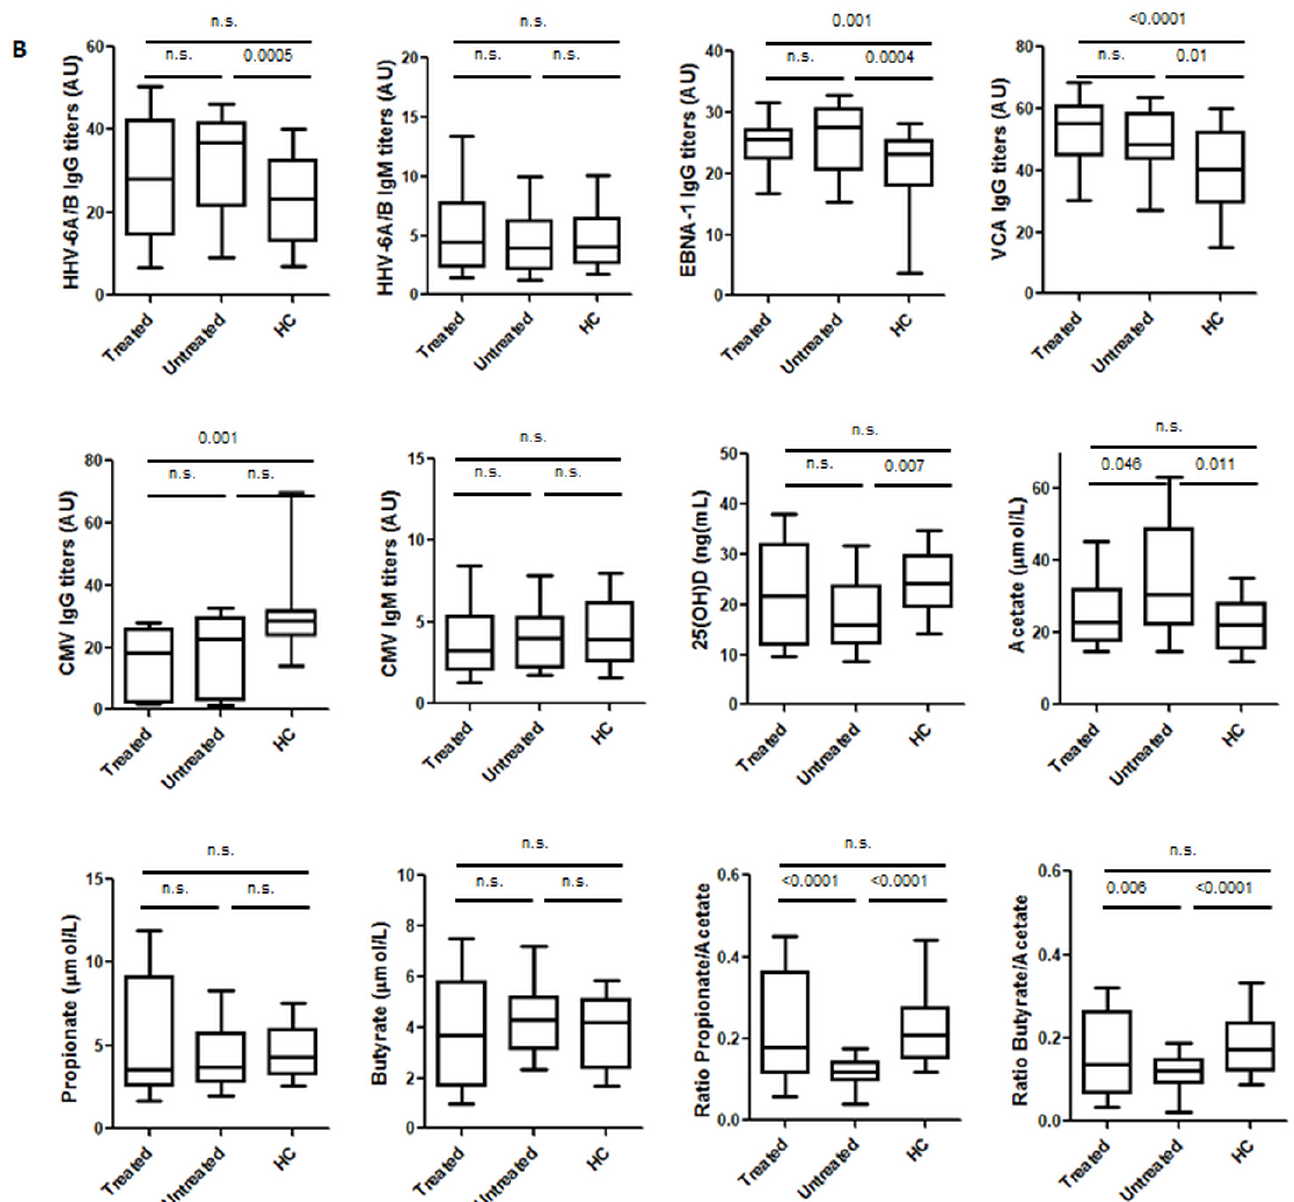
Figure 2. ( A ) Comparisons of the titers of the IgG and IgM viral antibodies, the levels of 25(OH)D, the levels of the three SCFA and PA/AA and BA/AA ratios between MS patients and HC. ( B ) MS patients were divided into those who were receiving treatment and those who were not at the time of sample collection. The upper line shows the comparison between treated MS patients and HC, the lower left line shows the comparison between treated and untreated MS patients and the lower right line shows the comparison between untreated MS patients and HC. Significant differences with the two-tailed t-test are shown (n.s.: not significant). Line inside the box shows the median value.